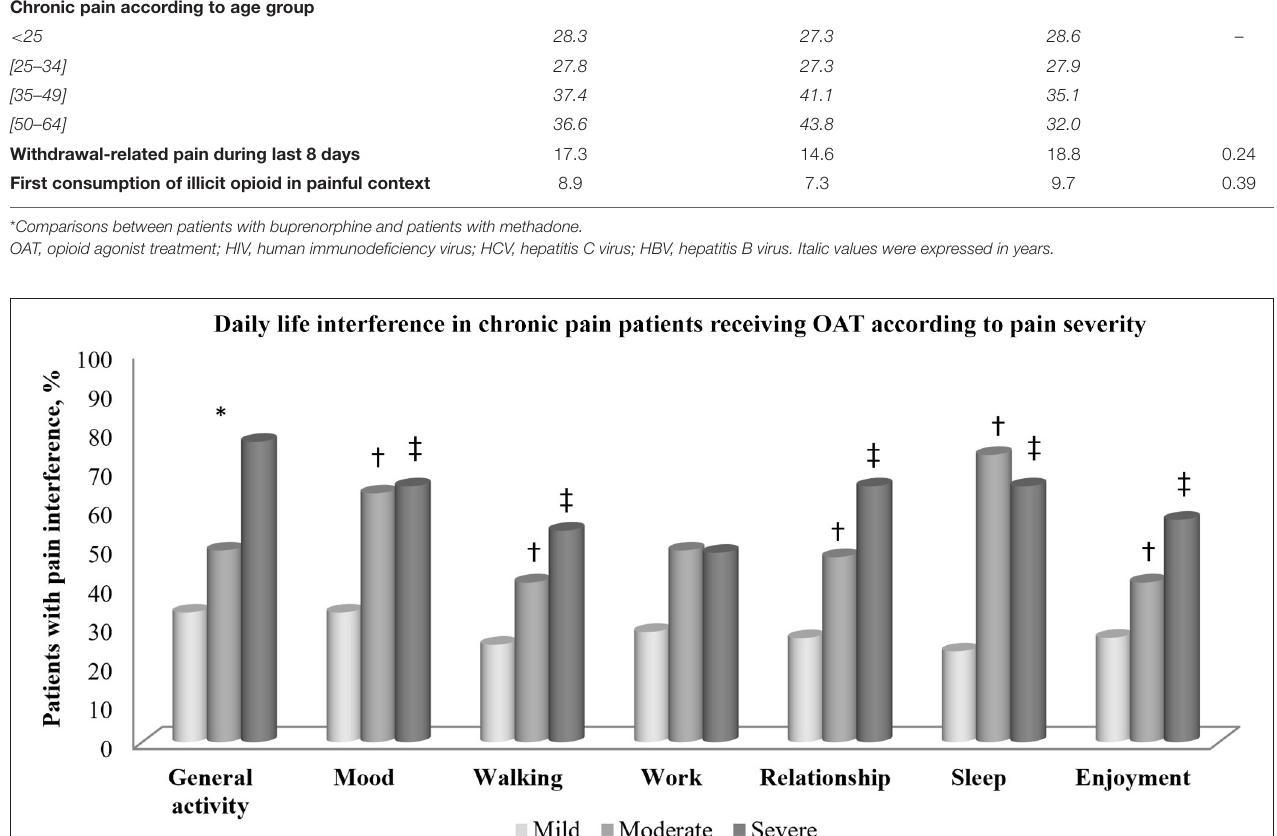
Patients receiving OAT n = 509